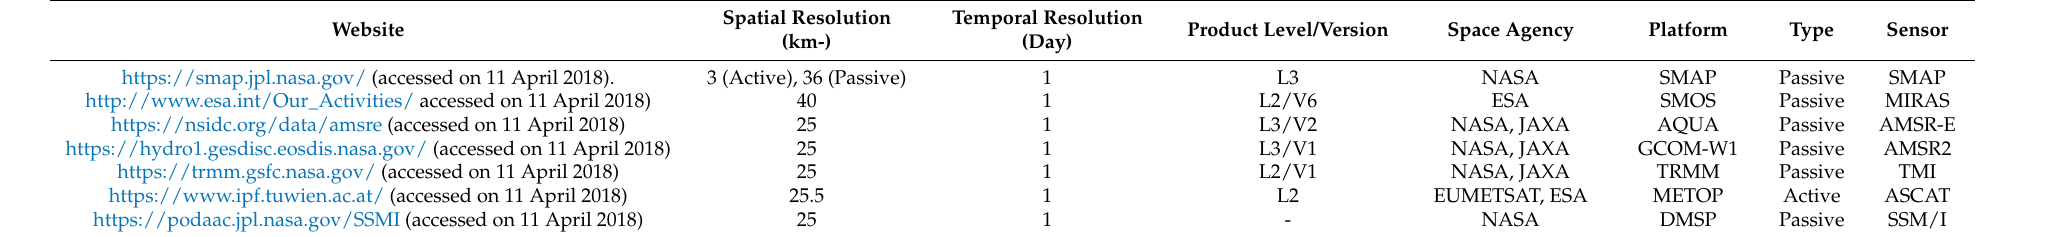
Table 1. Active and passive soil moisture